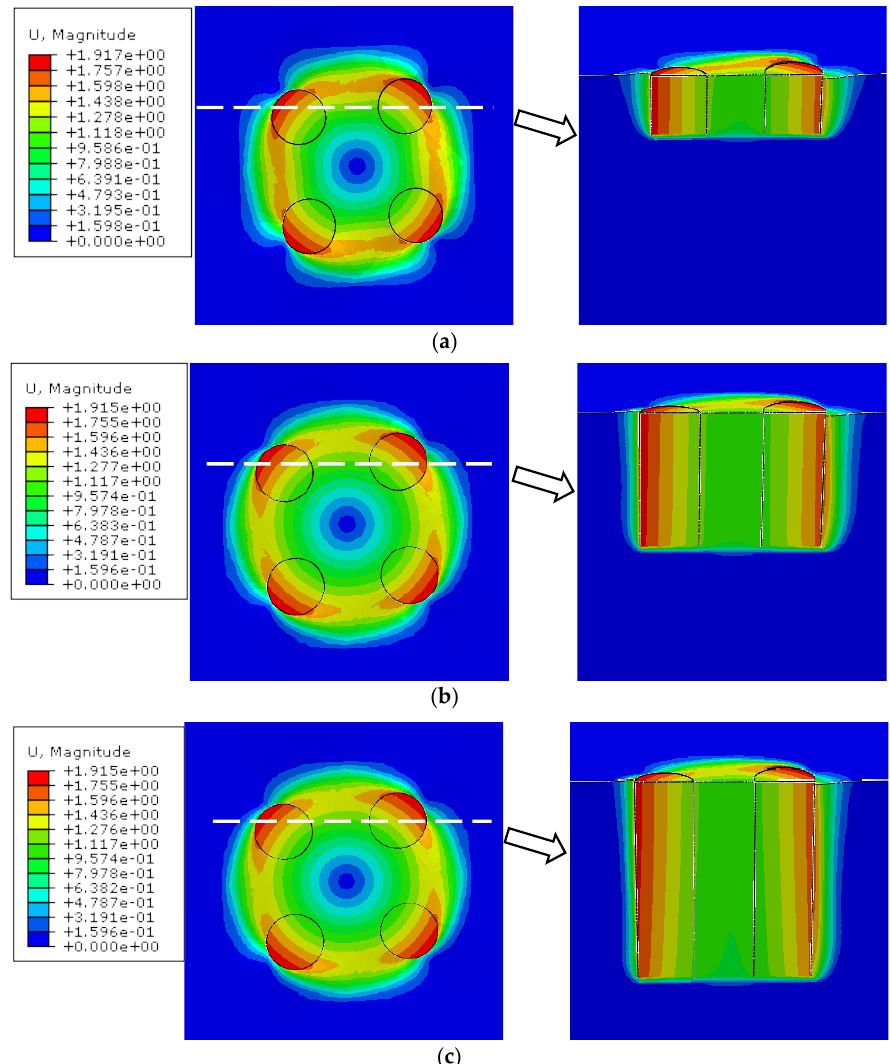
Figure 13. Displacement contours under torsional loading ( S / D = 1): ( a ) L / D = 1; ( b ) L / D = 2; ( c ) L / D = 3.